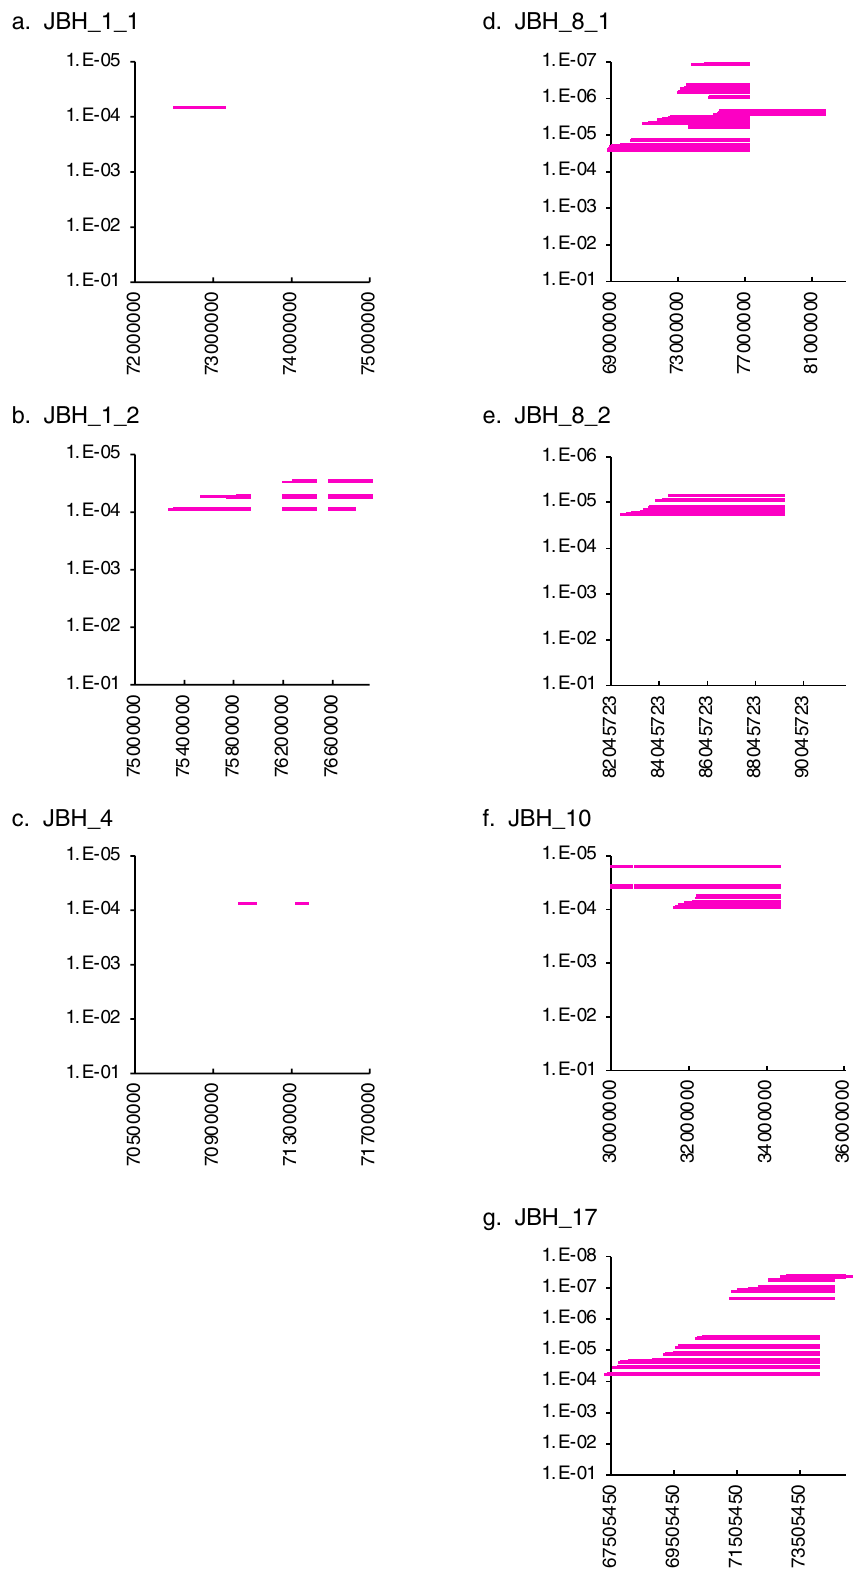
Figure 1. Distribution of the seven haplotypes with homozygous deficiency until an age of 25 months in Japanese Black cattle. ( a ) Japanese Black haplotype (JBH) _1_1. ( b ) JBH_1_2. ( c ) JBH_4. ( d ) JBH_8_1. ( e ) JBH_8_2. ( f ) JBH_10. ( g ) JBH_17. The overlapping haplotypes with a P value less than 10 –4 , calculated using the frequencies of homozygotes and carriers with a binomial test, were identified as the risk haplotype regions. Each red horizontal bar represents a haplotype with homozygosity deficiency. Positions on the X-axis are based on the UMD3.1 assembly of the bovine